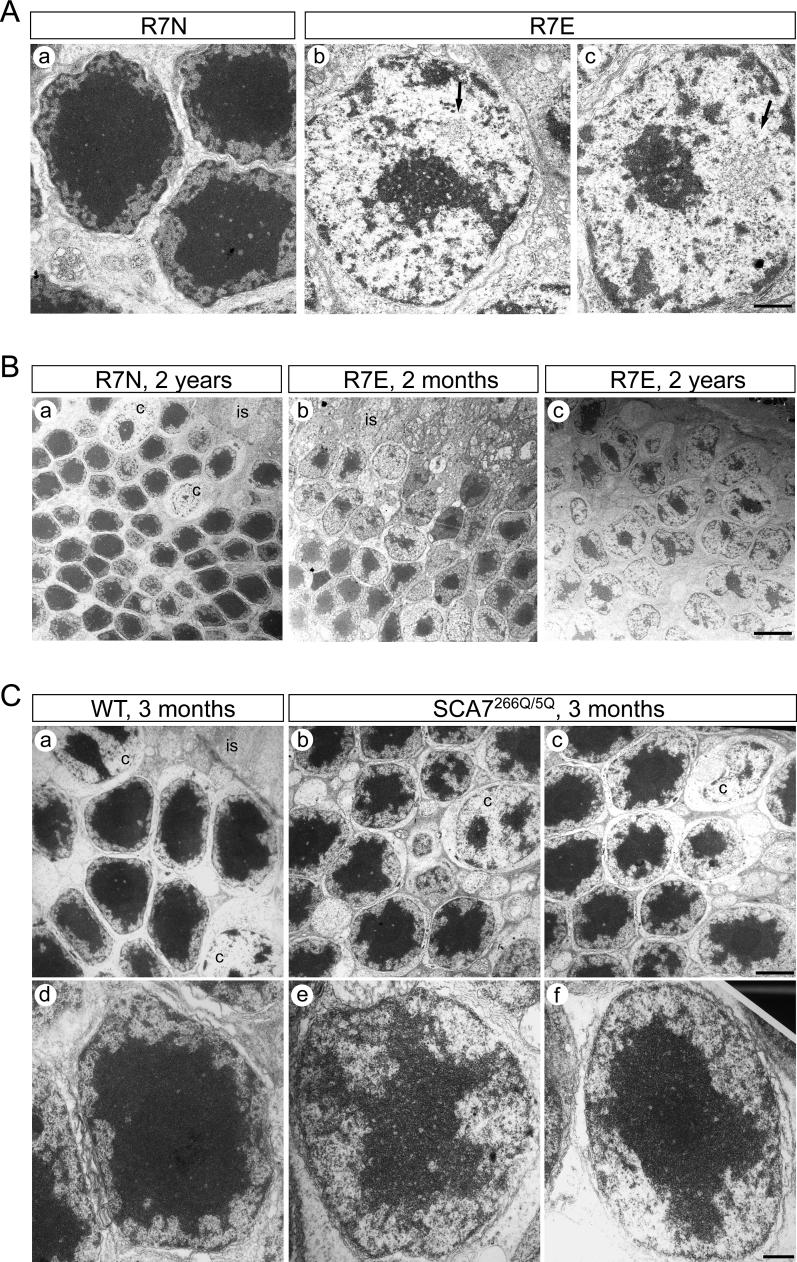
Severe Reorganization of Chromatin Territories in Rod Photoreceptors from SCA7 Mice(A) Ultrastructure of rod nuclei in R7E mice. Electron microscopy micrographs from 2-y-old R7N (panel a) and two distinct R7E (panels b and c) animals are shown. In R7N mice, rod nuclei are characterized by a large territory of centrally located heterochromatin. In R7E mice, rod nuclei were bigger and rounder, and displayed much more euchromatin, which appears lightly stained by electrons. Arrows indicate pale grey structures likely resulting from aggregation of mutant ATXN7 in rods from R7E mice. Scale bar represents 1 μm.(B) Ultrastructure of photoreceptor nuclei during disease progression in R7E mice. Electron microscopy micrographs from 2-y-old R7N (panel a), 2-mo-old R7E (panel b), and 2-y-old R7E (panel c) animals are shown. This time-course analysis revealed that alterations of rod nuclear architecture progressively worsened as retinopathy progressed in R7E mice. Cone photoreceptor nuclei (c), which are found in the outermost part of the ONL adjacent to inner segments (is), present a different architecture with several heterochromatin clumps surrounded by more euchromatin. As evidenced in panel c, rod nuclei in R7E mice look highly similar to cone nuclei. Scale bar represents 5 μm.(C) Ultrastructure of photoreceptor nuclei in SCA7 knock-in mice. Electron microsocopy micrographs from 3-mo-old WT (panels a and d) and two distinct age-matched SCA7266Q/5Q (panels b, c, e, and f) animals are shown. Morphological appearance of the central densely stained heterochromatin territory is altered in mutant mice. At higher magnification (lower panels [e–f]), rod nuclei from heterozygous knock-in animals are slightly larger and contain more euchromatin than nuclei from control mice. Cone nuclei (c) and photoreceptor inner segments (is) are depicted. Scale bars represent 2 μm in upper panels (a–c) and 0.5 μm in lower panels (e–f).